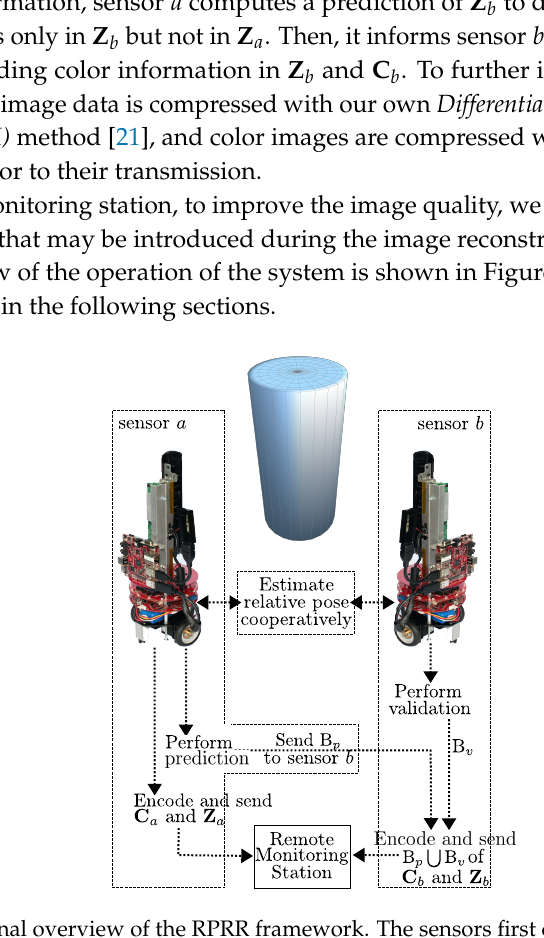
Figure 2. Operational overview of the RPRR framework. The sensors first cooperatively estimate their relative poses by using the algorithm shown in Figure 4, then, after identifying the non-overlapping image blocks, send only the non-redundant visual information to the remote monitoring station. Here, C a , C b and Z a , Z b are color and depth images obtained by sensors a and b , B p is the set of image block coordinates that can only be observed by sensor b , and B v is the set of image block coordinates covering the regions that sensor a incorrectly estimates as visible by sensor b